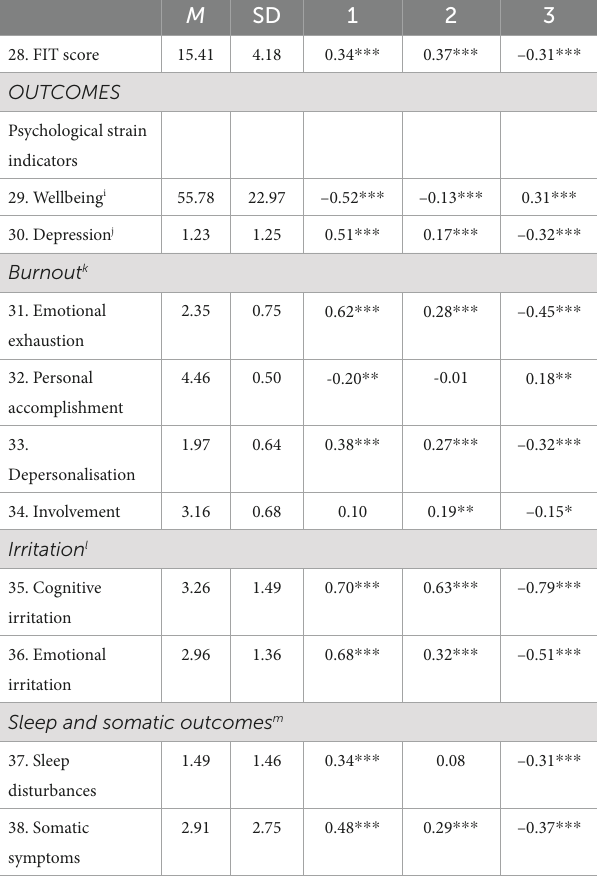
TABLE 6 Means, standard deviations and zero-order correlations of study